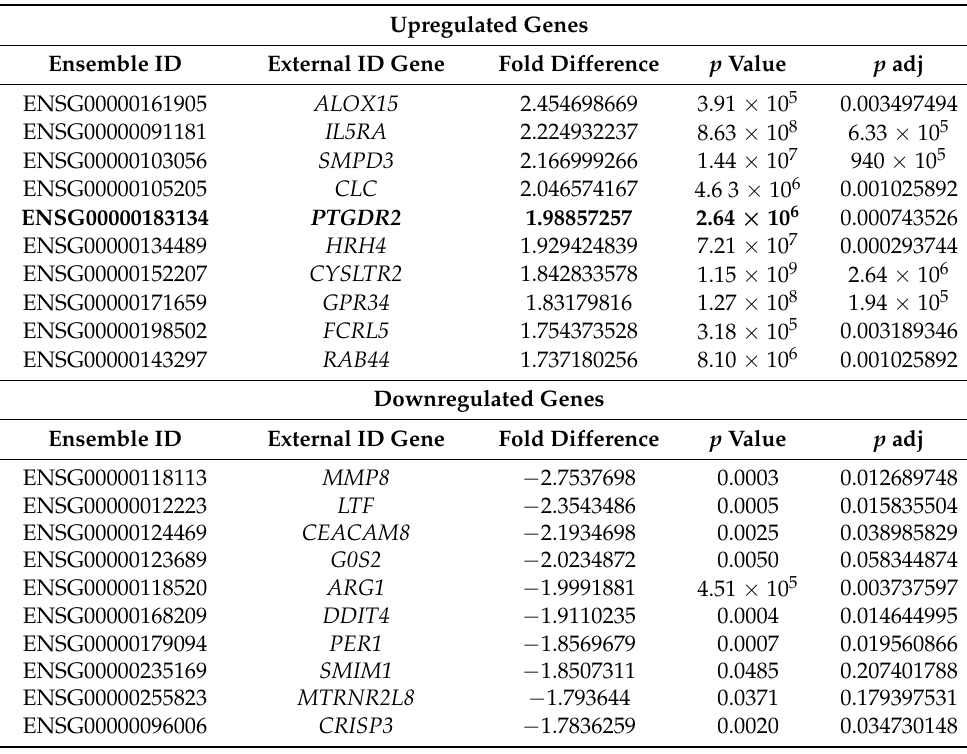
Table 2. Protein-coding transcripts most differentially expressed between patients with allergic asthma and controls. PTGDR2 gene is highlighted in bold.